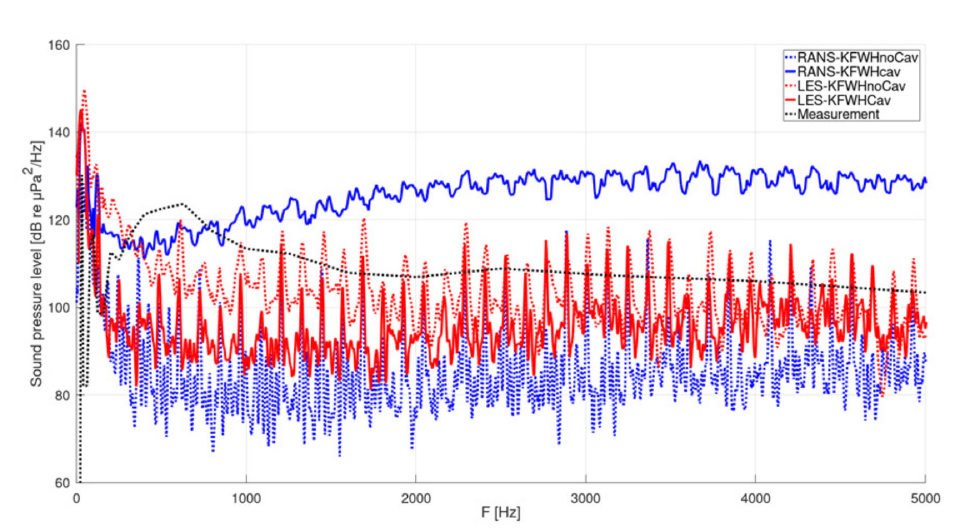
Figure 7. P1595. Sound pressure level spectral evaluation at observer: comparison of KFWH approach under cavitating and non-cavitating conditions with experimental measurements from SINTEF Ocean.